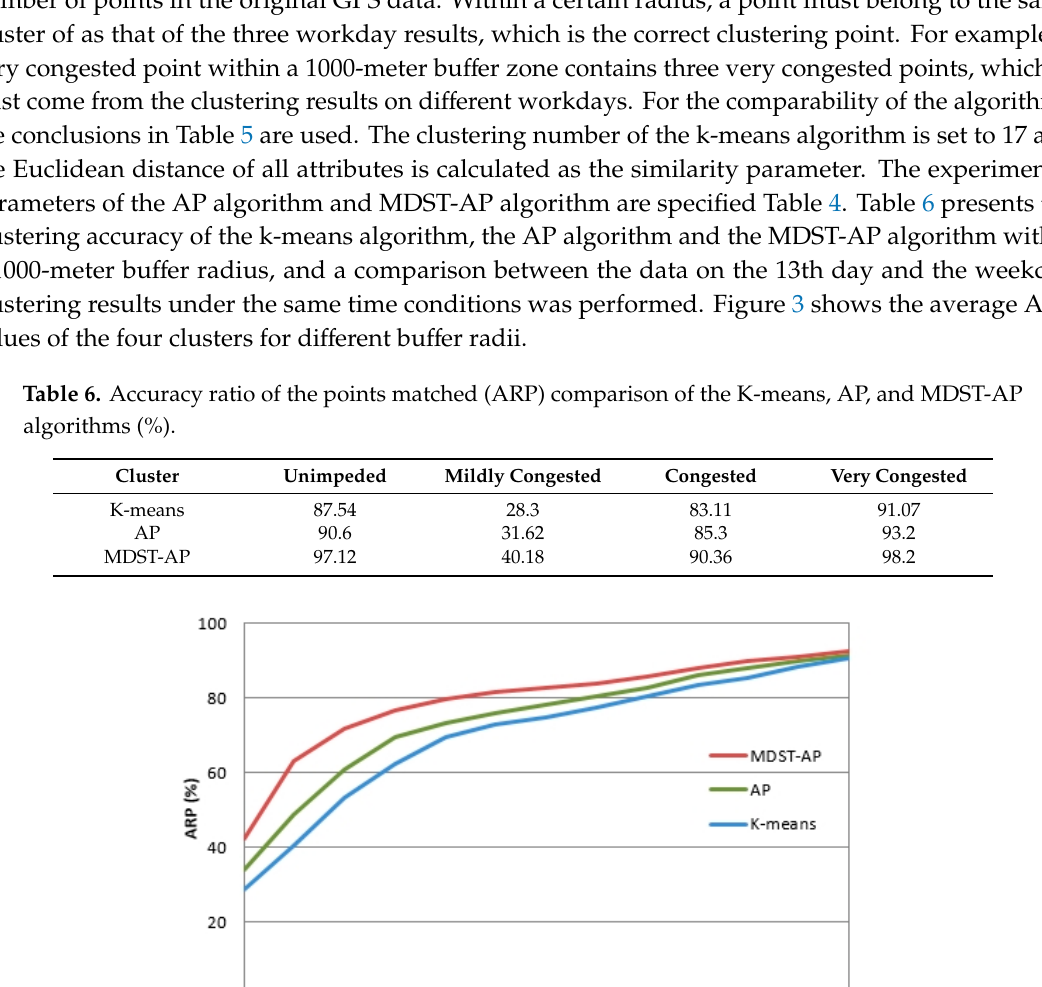
Table 6. Accuracy ratio of the points matched (ARP) comparison of the K-means, AP, and MDST-AP algorithms (%). Cluster